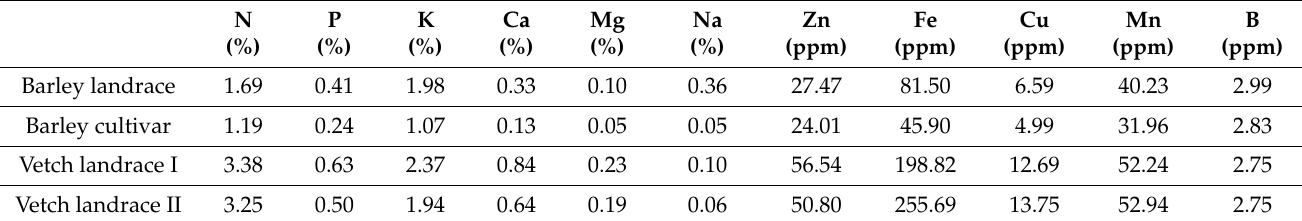
Table 1. Chemical analysis of macro and micro elements of barley ( Hordeum vulgare ) and vetch ( Lathyrus sp.) landraces.